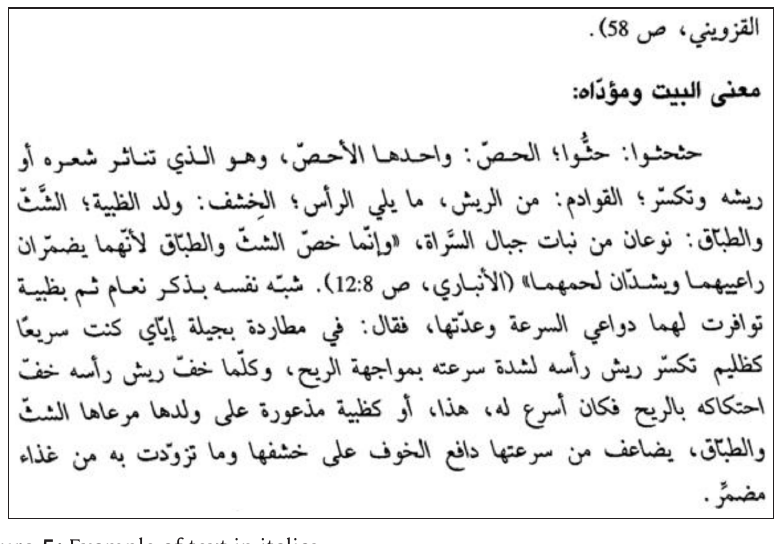
Figure 5: Example of text in italics.